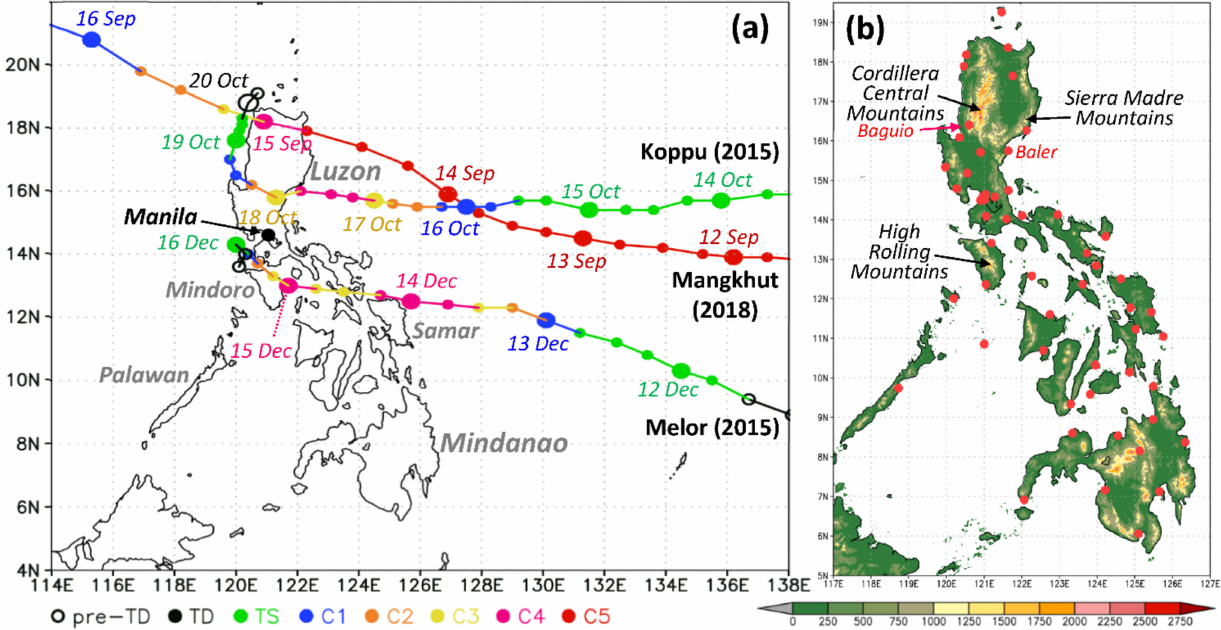
Figure 1. ( a ) The geography of the Philippines and the JTWC’s best tracks of the three typhoons in this study (center positions given every 6 h, with dates labeled at 0000 UTC) with intensity indicated (color, see legend below). Major islands and the capital city of Manila are labeled. ( b ) The topography (m, color), major mountains, and locations of rain gauges (red dots) in the Philippines. Rain gauge sites where maximum rainfall was observed are labeled (see text for